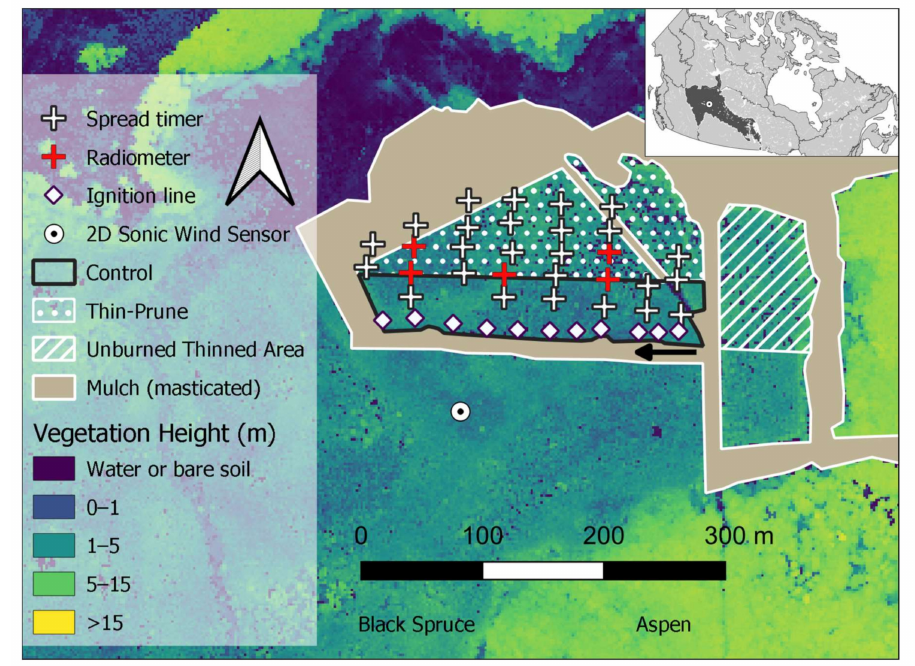
Figure 1. Plot layout and vegetation height. Ignition commenced on the southeast corner and proceeded